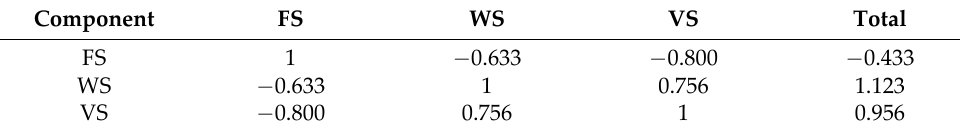
Figure 6. Sample distribution of the ESST ( left ) and its standardized model ( right ). Note: FS: farm‑ land services. WS: water services. VS: vegetation services. Table 5. Response rate of three types of ESVs to unit